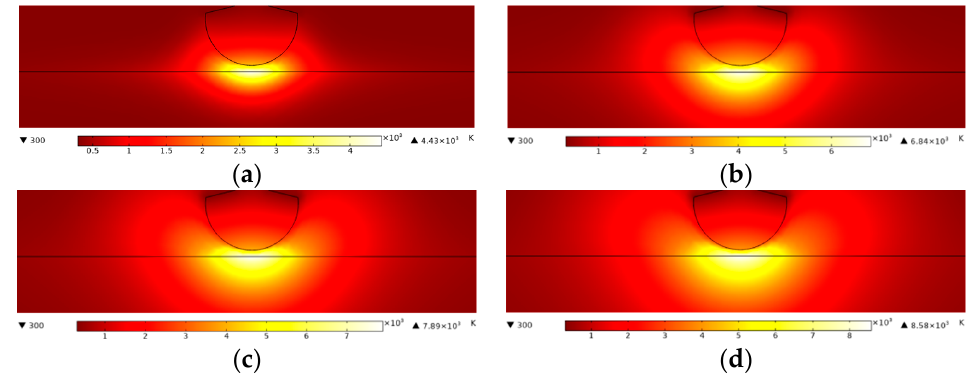
Figure 3. Temperature distribution cloud diagram of the pantograph–catenary arc (when gap is 1mm). ( a ) 0.1 s cloud chart of arc temperature distribution; ( b ) 0.4 s cloud chart of arc temperature distribution; ( c ) 0.7 s cloud chart of arc temperature distribution; ( d ) 1 s cloud chart of arc temperature distribution.